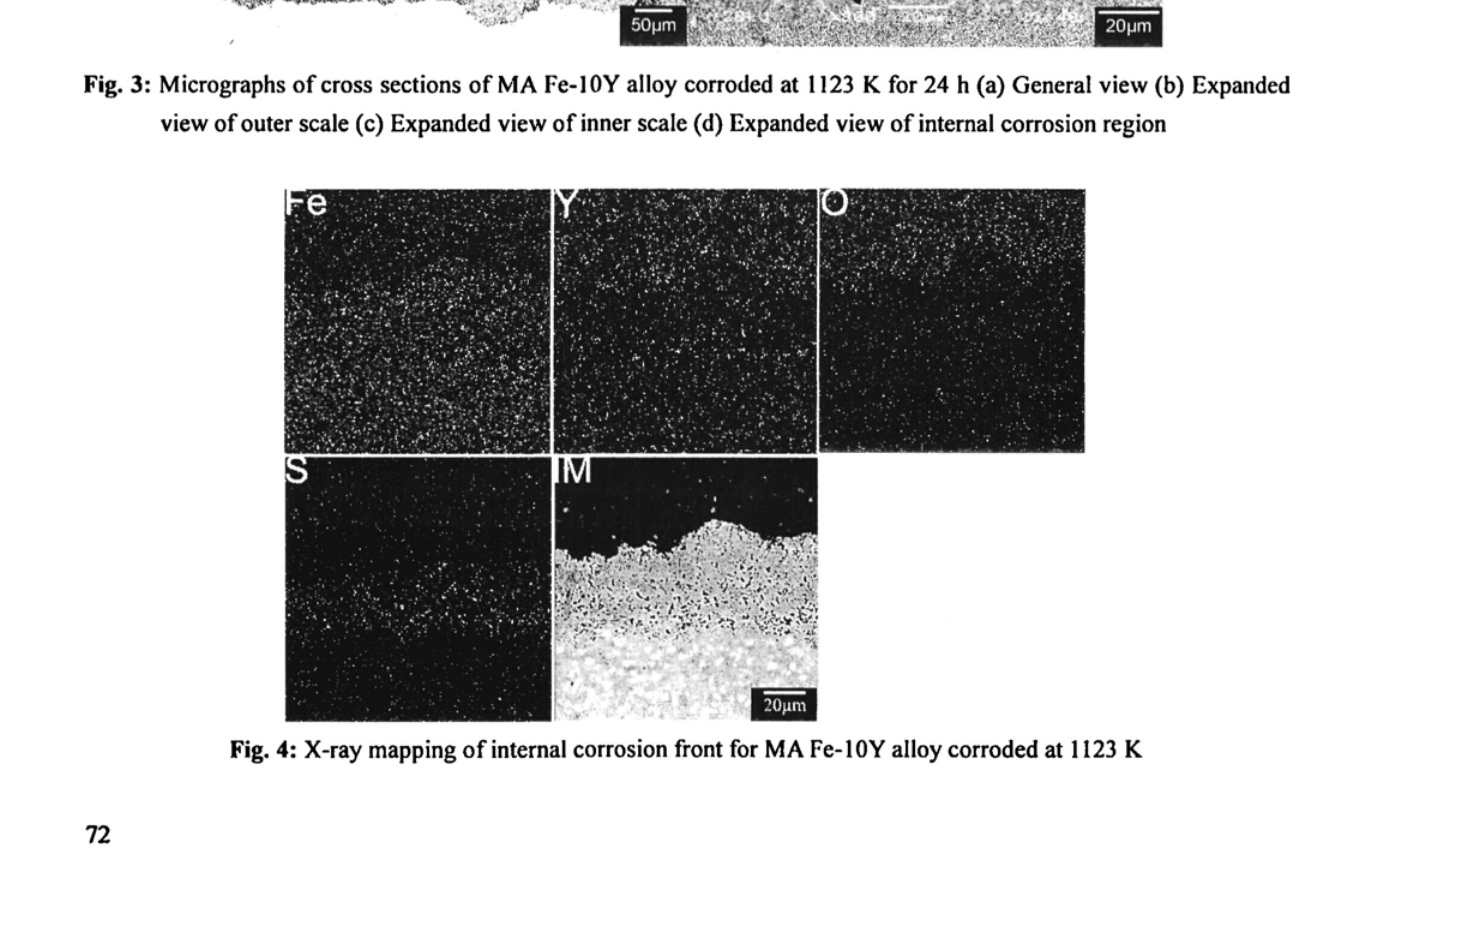
Fig. 3: Micrographs of cross sections of MA Fe-10Y alloy corroded at 1123 Κ for 24 h (a) General view (b) Expanded view of outer scale (c) Expanded view of inner scale (d) Expanded view of internal corrosion region